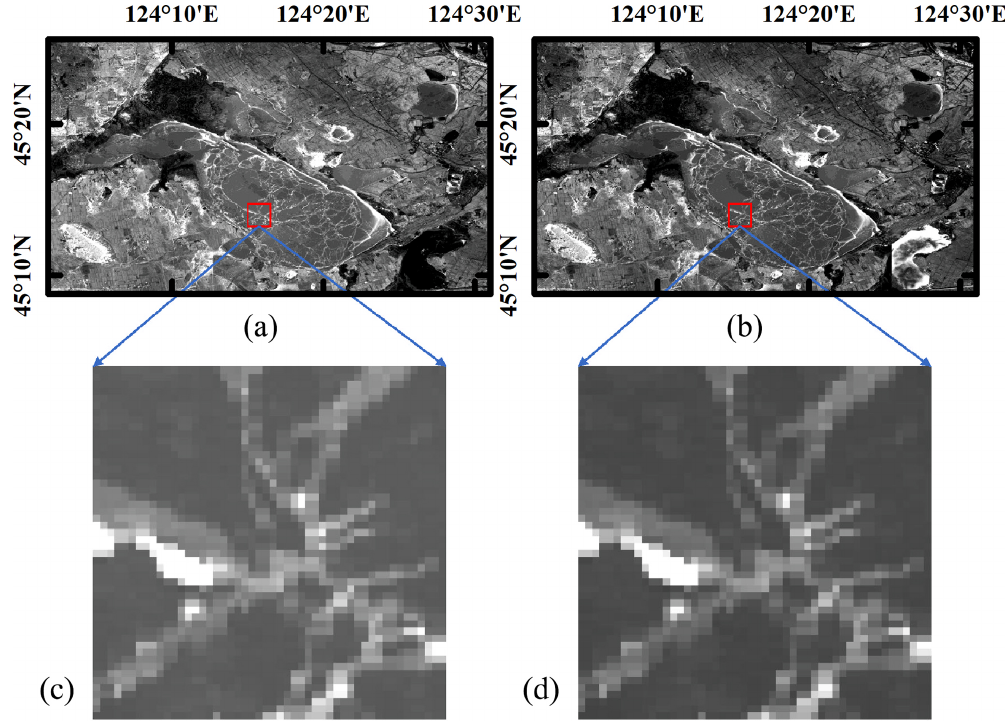
Figure 3. The actual image observed on 22 November 2018 (a) and its prediction images by the ESTARFM (b) . Panels (c) and (d) display the magnified version of the red rectangle in panels (a) and (b) , respectively.